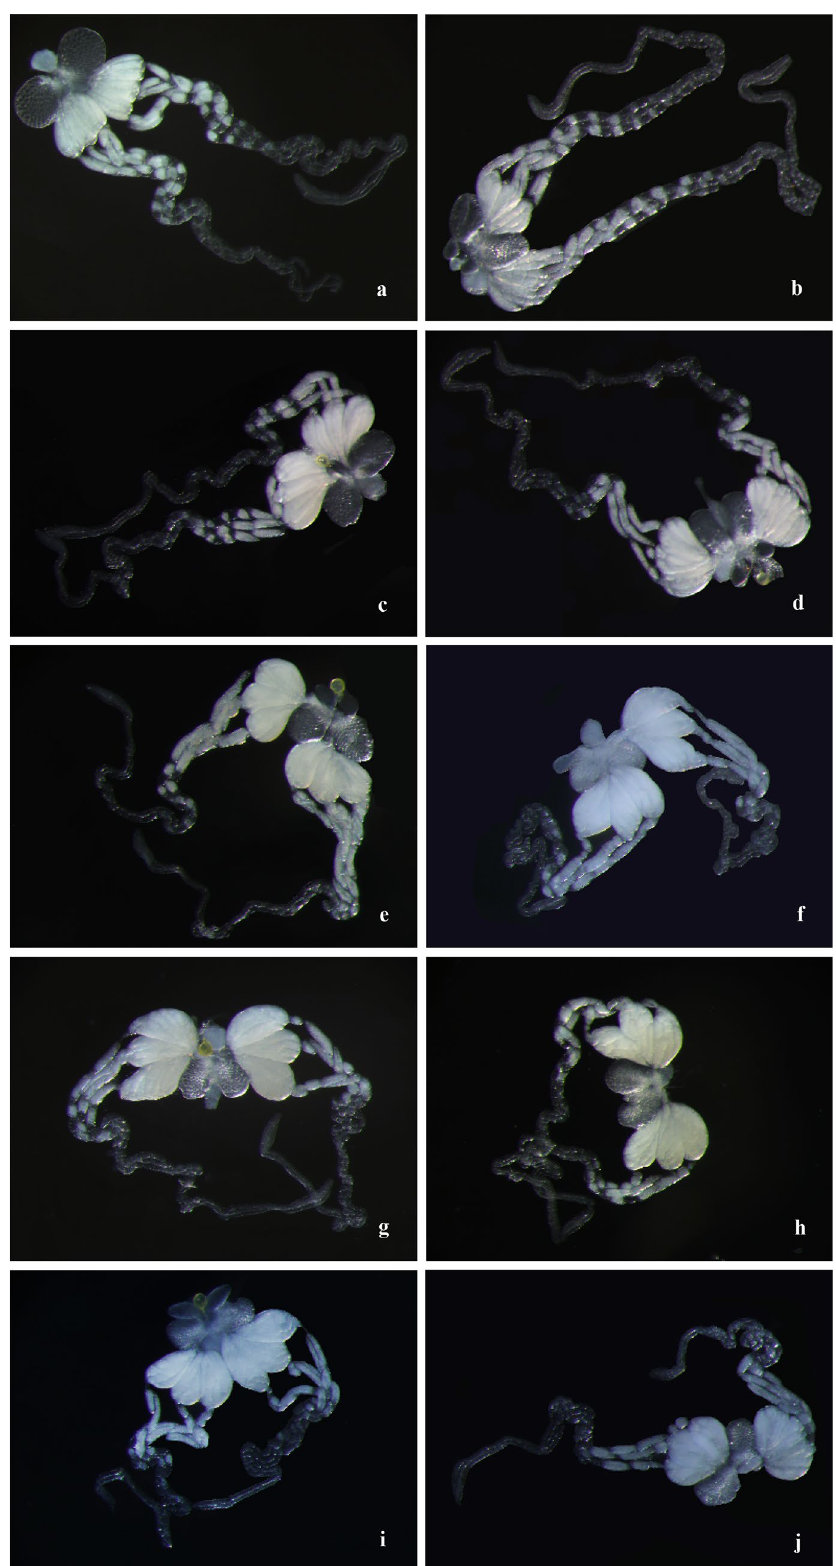
Figure 2. The ovarian development of unmated and mated C. japonicus over time after emergence (115 ×). ( a ) The ovary of unmated female that have emerged for 2 h; ( b ) the ovary of mated female that have emerged for 2 h; ( c ) the ovary of unmated female that have emerged e for 1 days; ( d ) the ovary of mated female that have emerged for 1 days; ( e ) the ovary of unmated female that have emerged for 5 days; ( f ) the ovary of mated female that have emerged for 5 days; ( g ) the ovary of unmated female that have emerged for 10 days; ( h ) the ovary of mated female that have emerged for 10 days; ( i ) the ovary of unmated female that have emerged for 15 days; ( j ) the ovary of mated female that have emerged for 15